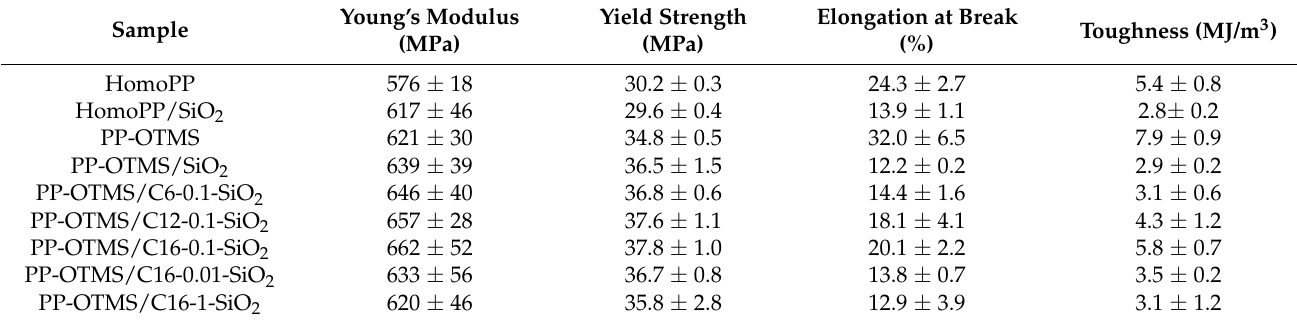
Table 3. Tensile properties of